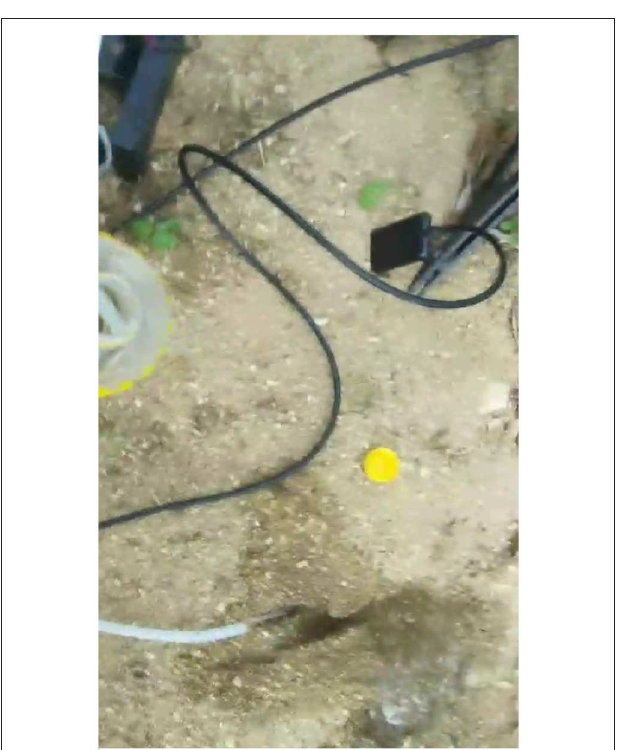
FIGURE 7 | Activation of the sprinkler systems.